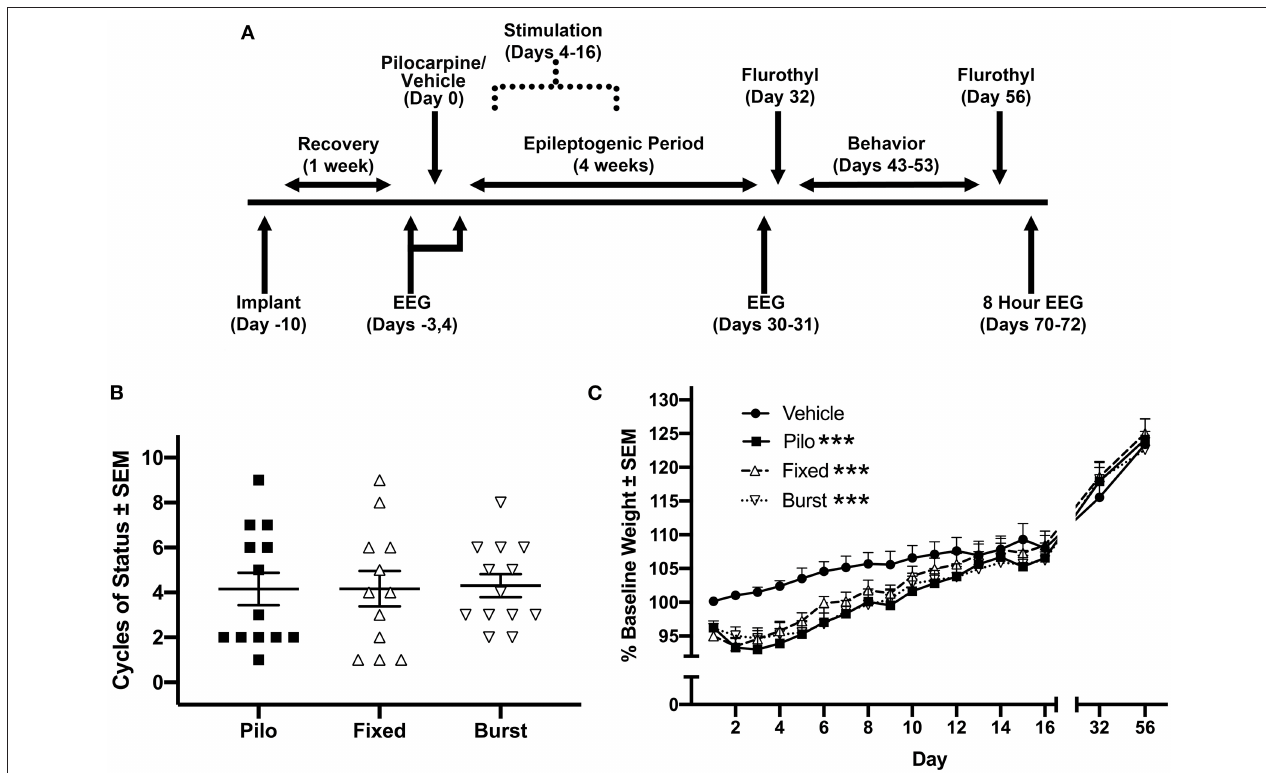
FIGURE 1 | Experimental timeline and biological measures post-pilocarpine injection. (A) Timeline of procedures. We allowed 4 weeks, operationally defined as the epileptogenic period, from the time of pilocarpine for rats to develop spontaneous seizures. (B) Stimulation groups were counterbalanced via cycles of status epilepticus and (C) weight following pilocarpine injection. Each of the three pilocarpine-treated groups were statistically different from vehicle across the first 16 days following pilocarpine administration. However, there were no statistical differences between any of the pilocarpine-treated groups. *** p < 0.001.